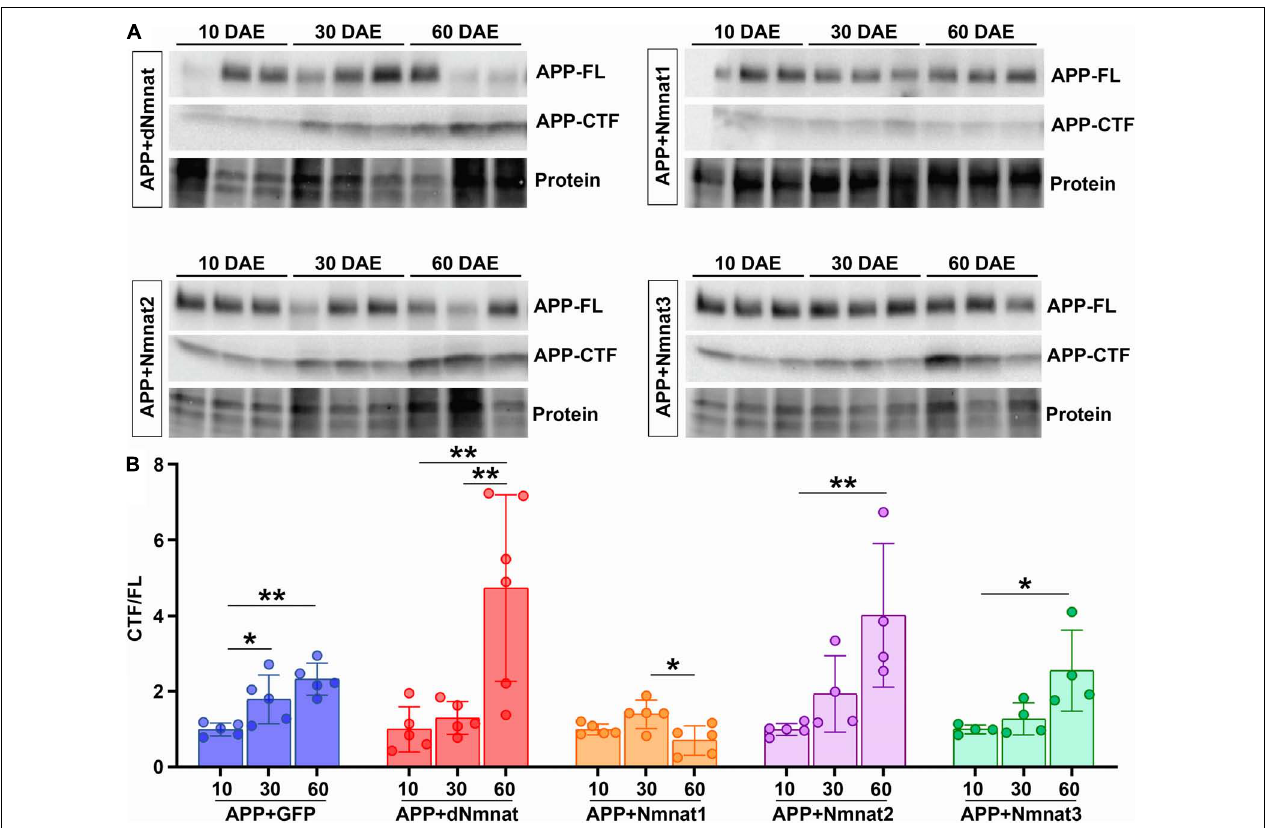
FIGURE 3 | hNmnat1 reduces APP cleavage and production of APP-CTF in the brain. (A) Western-blot analysis of full-length amyloid precursor protein (APP-FL) and C-terminal fragment (APP-CTF) of 10, 30, and 60 DAE flies expressing APP + dNmnat, APP + hNmnat1, APP + hNmnat2, or APP + hNmnat3. Stain-Free imaging of a representative portion of the membrane is presented to show the protein loading. (B) Quantification of CTF/FL ratio in each group. Data are expressed as mean ± SD. n = 4–6/group. One-way ANOVA with Bonferroni’s post hoc test. * P < 0.05, ** P <